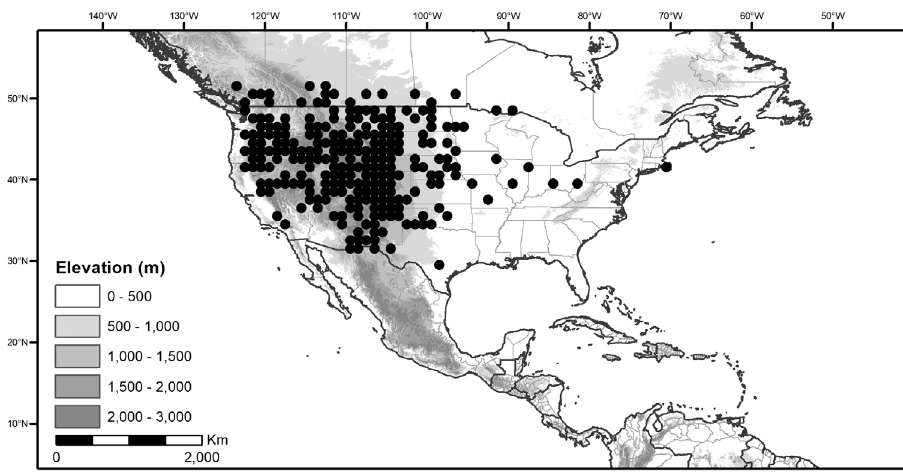
Figure 53. Distribution of Solanum triflorum